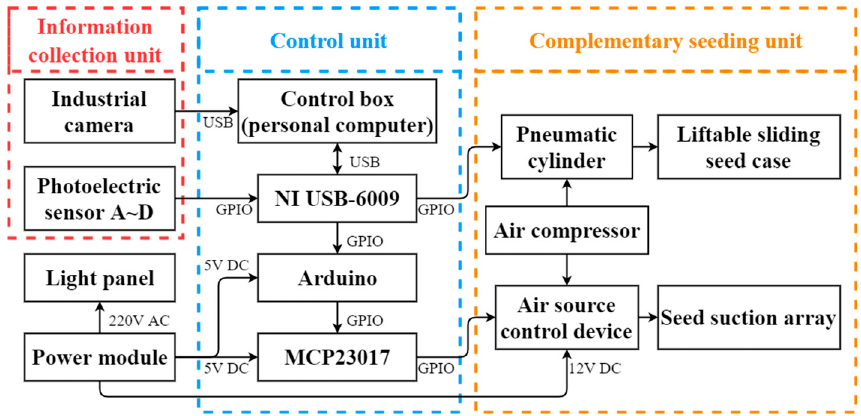
Figure 2. Hardware system.